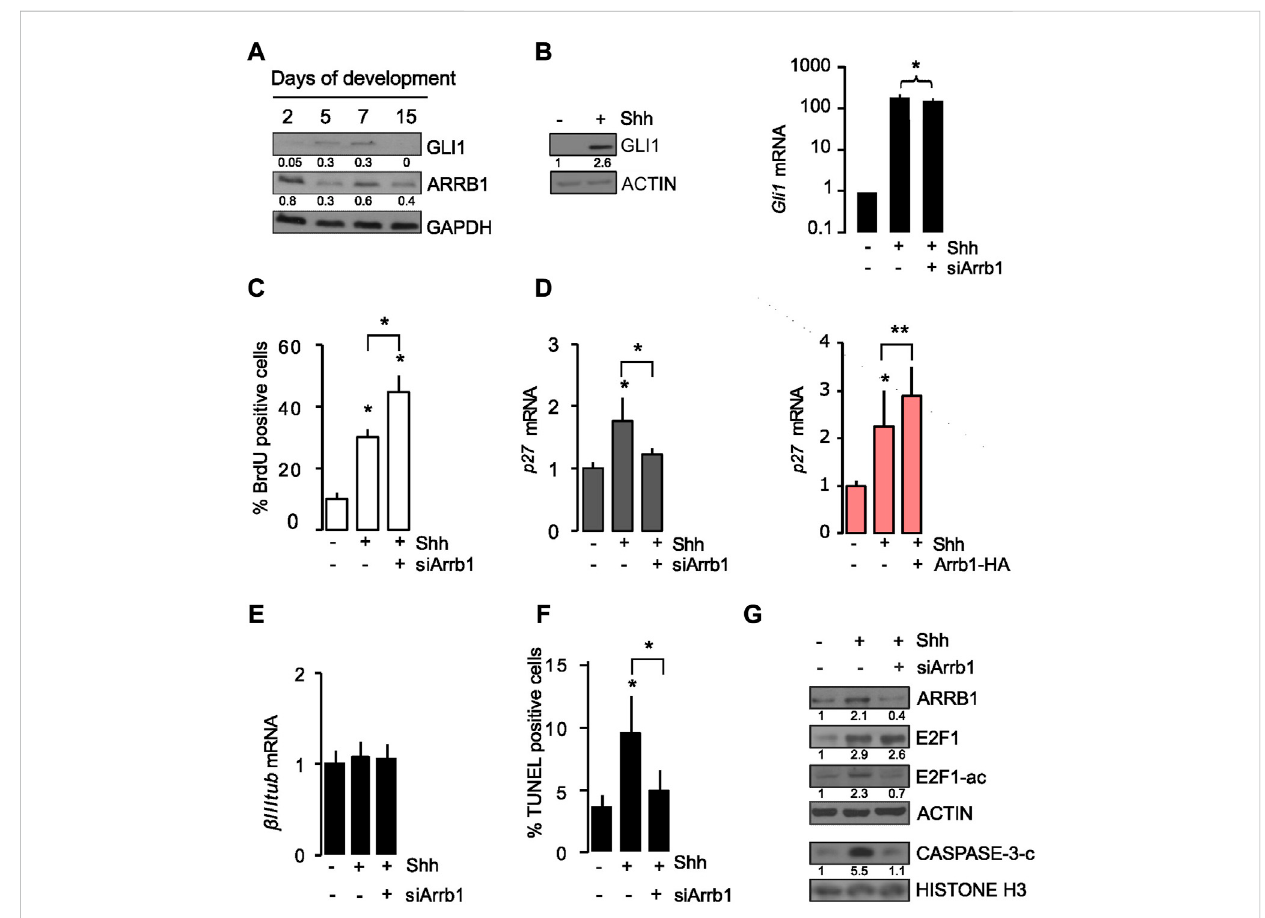
FIGURE 1 ARRB1 controls cell proliferation and apoptosis in granule cell progenitors (GCPs) via E2F1 acetylation. (A) Murine cerebellum Western blot. Representative images of endogenous GLI1 and ARRB1 in murine cerebella at different days (2, 5, 7, 15) of cerebellar development. GAPDH: loading control. (B – G) GCPs experiments. Shh was added to cultures of murine cerebellar GCPs that had or had not undergone siRNA-mediated silencing of ARRB1 (siArrb1). After 48 h of Shh stimulation, GCPs were assayed for: (B) Gli1 mRNA and protein levels (as a read-out of Shh signaling activity), and ARRB1 protein level; ACTIN as loading control; (C) proliferation re fl ected by bromodeoxyuridine (BrdU) uptake; (D) left: p27 mRNA levels ( (D) right and Supplementary Figure S4B: Overexpression data are consistent); (E) differentiation re fl ected by β III tubulin mRNA levels; (F) apoptosis evaluated by TUNEL assay, and (G) ARRB1, E2F1, E2F1-ac, cleaved CASPASE-3 protein expression levels. ACTIN and HISTONE H3: loading controls. For Western blot, densitometryvaluesareshownbelowtheblotsanddensitometricgraphsarepresentedinSupplementaryFigureS2.Datarepresentmeans±S.D.,fromat least three independent experiments; * p < 0.05; ** p < 0.01; *** p <